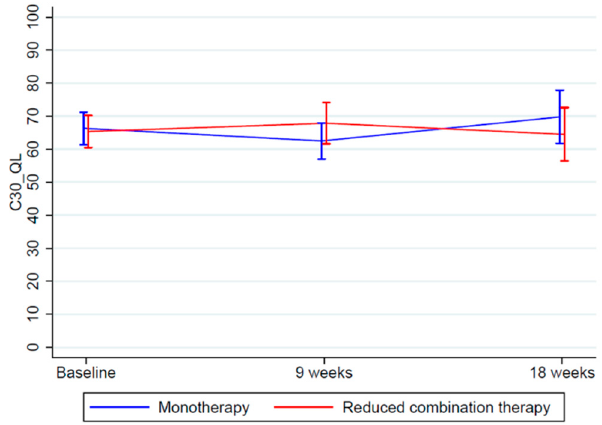
Figure 2. Global QoL over time as line-diagram with 95% CI at baseline, at 9-week and at 18-week follow-ups. Higher values indicate better global QoL. follow-ups. Higher values indicate better global